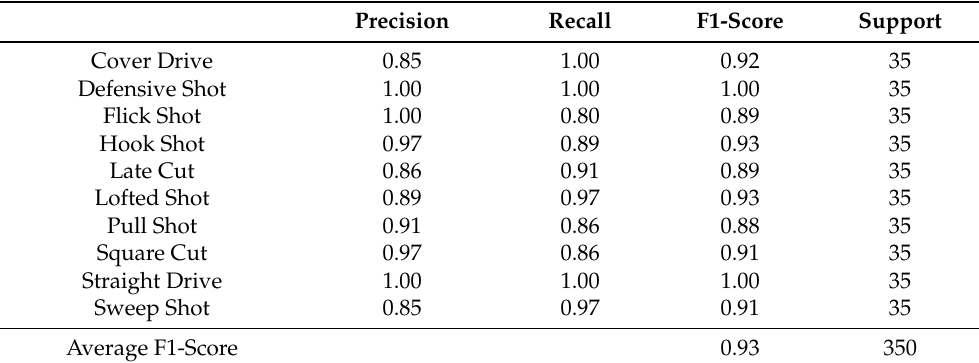
Table 10. Classification report for Model